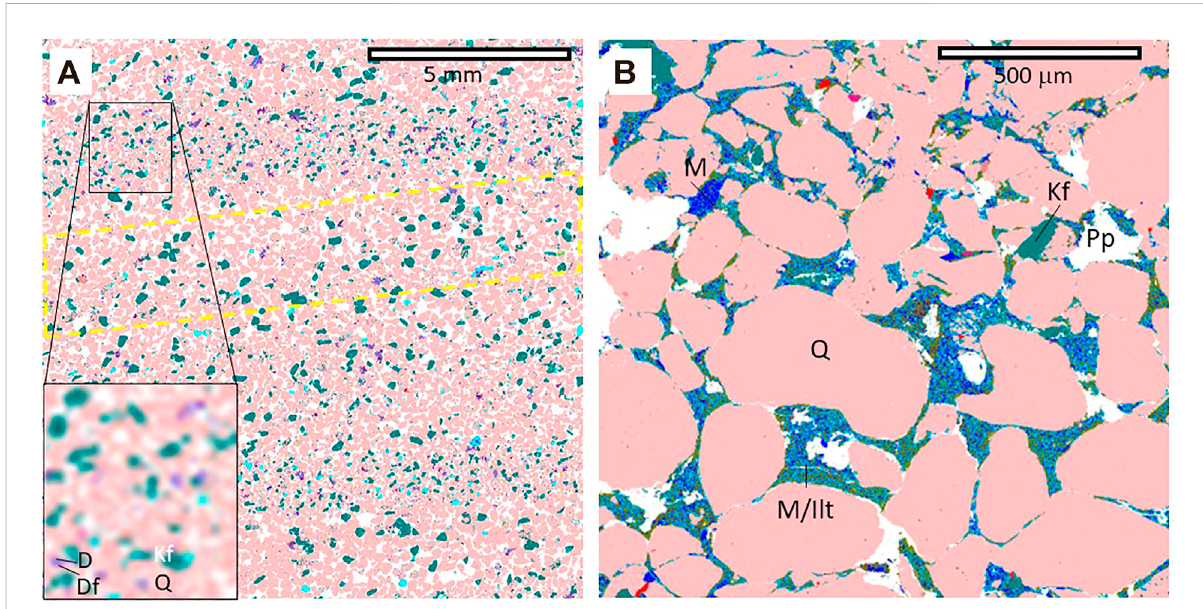
FIGURE 10 Grain size and matrix effects on reservoir quality. (A) Low magni fi cantion image Lower Triassic aeolian sandstone from the East Irish Sea Basin, United Kingdom with the sand dominated by quartz (Q) with minor K-feldspar (Kf) and dispersed dolomite (D) cement with a outer rim of ferroan dolomite(Df)(mineralcolourindexinFigure3).Beds,exempli fi edbytheyellowdashedlines,resultfromgrain fl owdowntheslipfaceoflargeTriassic sand dunes. Beds have distinctly different grain sizes. These grain size differences will lead to bed-controlled variations of permeability as the coarser sands have larger pores and pore throats. (B) Triassic continental sandstone from the Irish Sea Basin, United Kingdom, with abundant pore fi lling muscovite-illite (M/Ilt) and little primary porosity (Pp). The muscovite-illite may have been a depositional component of the sandstones (i.e., matrix) or it may have resulted from the alteration of detrital K-feldspar before petroleum fi lling stopped this water-induced diagenetic reaction (Woodward and Curtis, 1987; Cowan and Boycott-Brown,